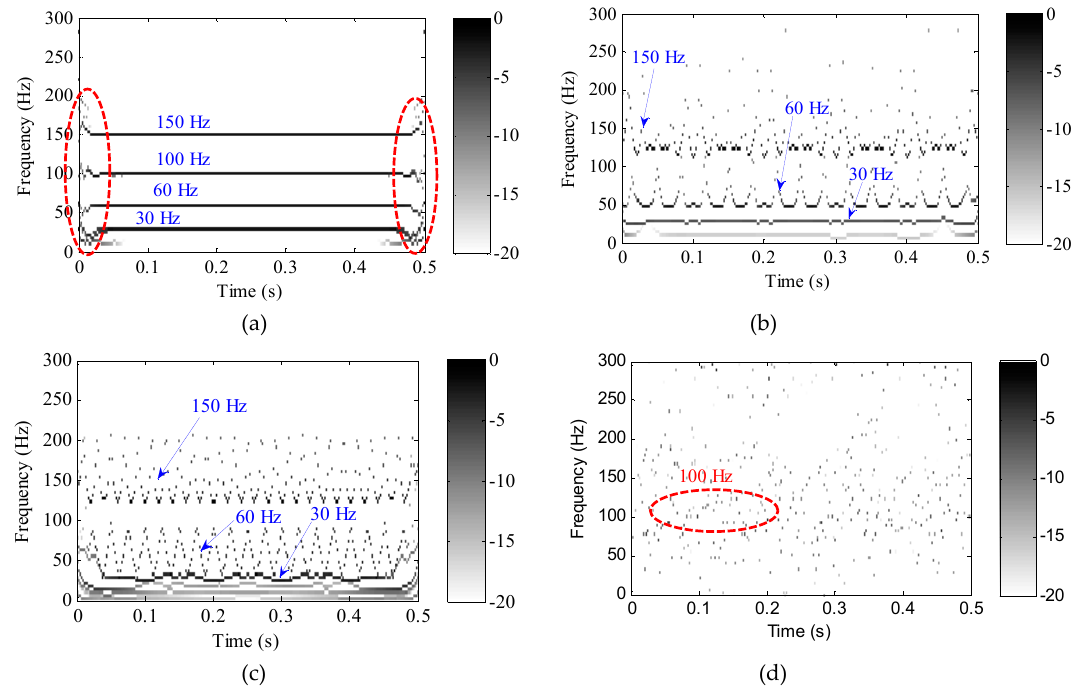
Figure 12. The time-frequency representations obtained by different methods for simulation 1: ( a ) OVMD, ( b ) LMD, ( c ) EMD, and ( d ) WT.